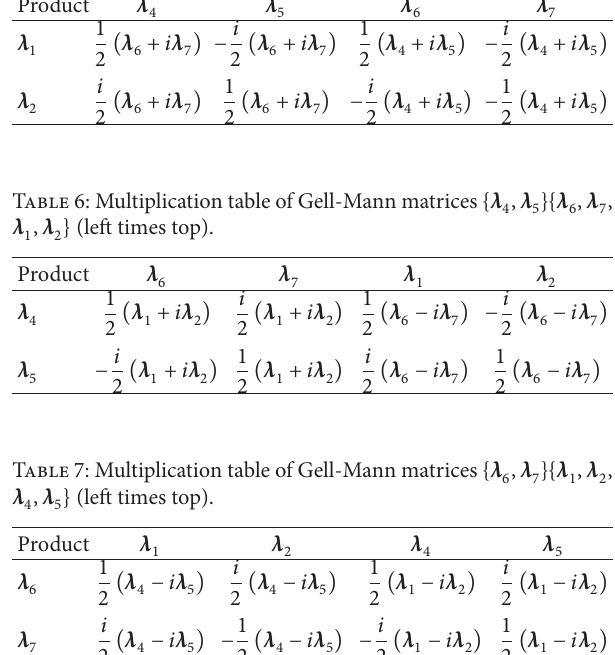
and are such that U −1 (𝜗) = U † (𝜗) = U T (𝜗) = U